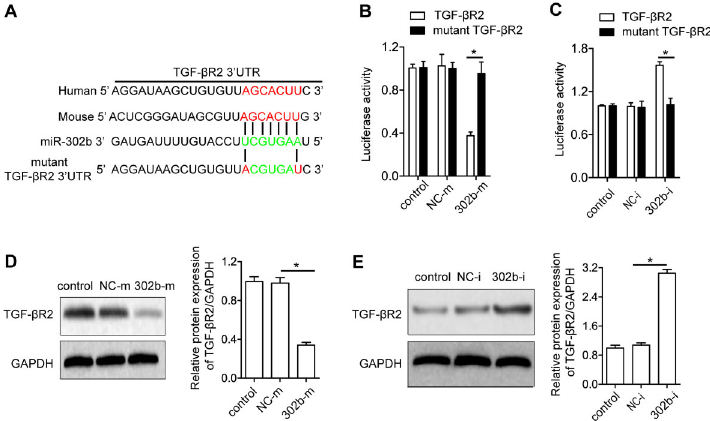
Figure 4. Identi fi cation of transforming growth factor (TGF)- b R2 as a target gene of miR-302b. A , Diagram of TGF- b R2 3 0 -UTR as a putative target for miR-302b in human and mouse. The seed-recognizing sites are indicated in red and mutated sequences are shown in green. Dual luciferase activity assay was performed in HK2 cells by co-transfection of luciferase reporter containing human wild type or mutant TGF- b R2 3 0 -UTR and miR-302b mimic (20 nM) ( B ), miR-302b inhibitor (20 nM) ( C ), or respective control sequences. miR-302b mimic decreased TGF- b R2 protein expression ( D ), and miR-302b inhibitor increased TGF- b R2 protein expression ( E ). Data are reported as means ± SE (n=8). *P o 0.05 (Student ’ s t -test or ANOVA). NC-m: miR-302b mimic negative control, 302b-m: miR-302b mimic, NC-i: miR-302b inhibitor negative control, 302b-i: miR-302b